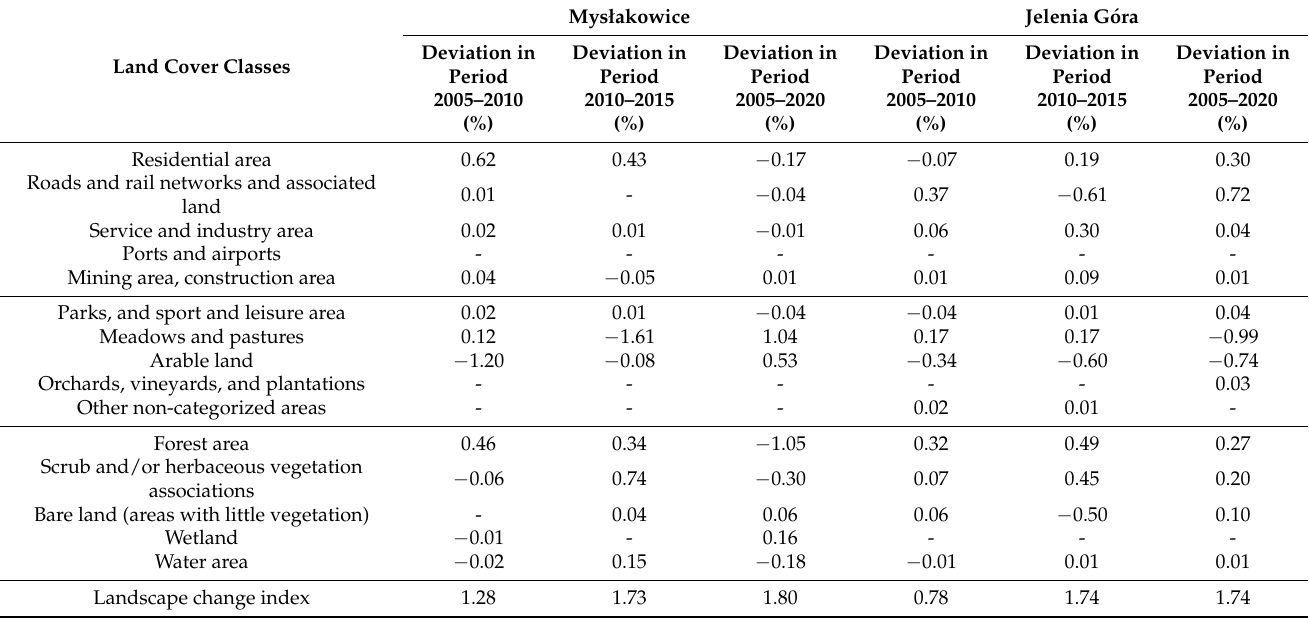
Table 2. The percentage of deviation for the types of land cover in the communities of Mysłakowice and Jelenia G ó ra in the analyzed